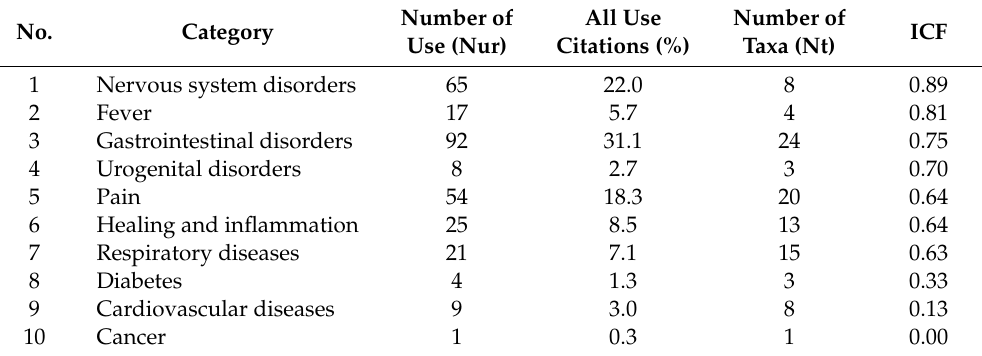
Table 3. Informant consensus factor (ICF) values of category of